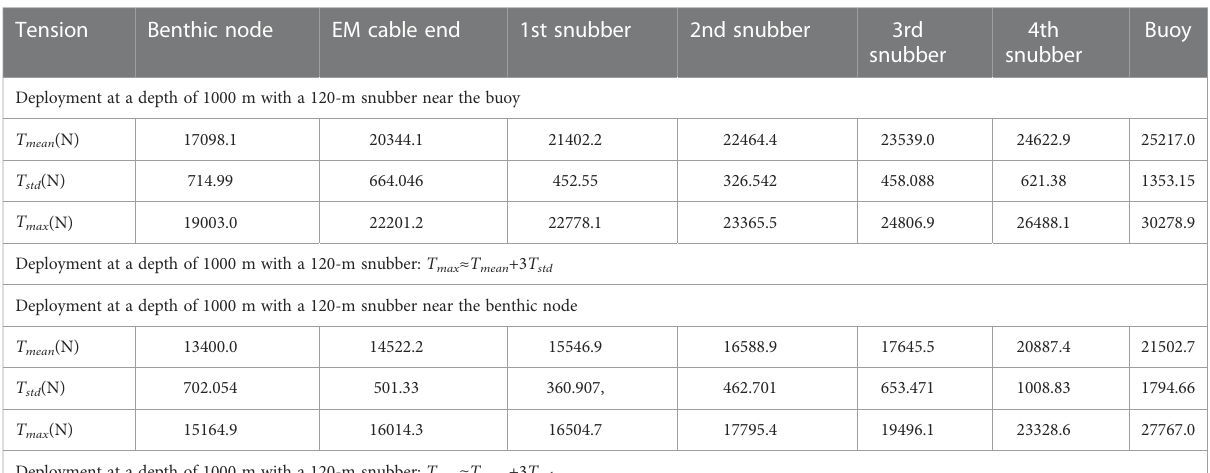
TABLE 9 Tension from the dynamic analysis for the snubber in different positions. Tension Benthic node EM cable end 1st snubber 2nd snubber 3rd